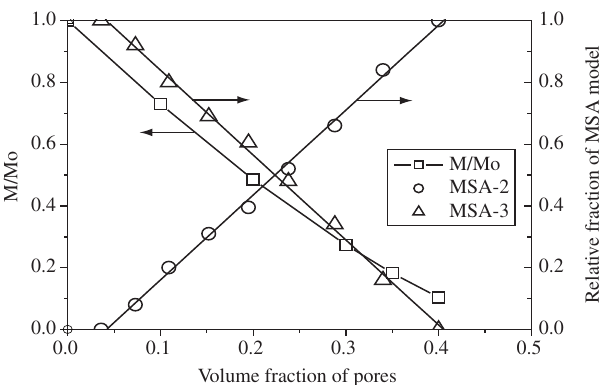
Figure 6. Relative elastic modulus and relative fraction of MSA model versus porosity. MSA-2 is the model of spherical particles in cubic stacking and MSA-3 is the model of spherical pores in cubic stacking.